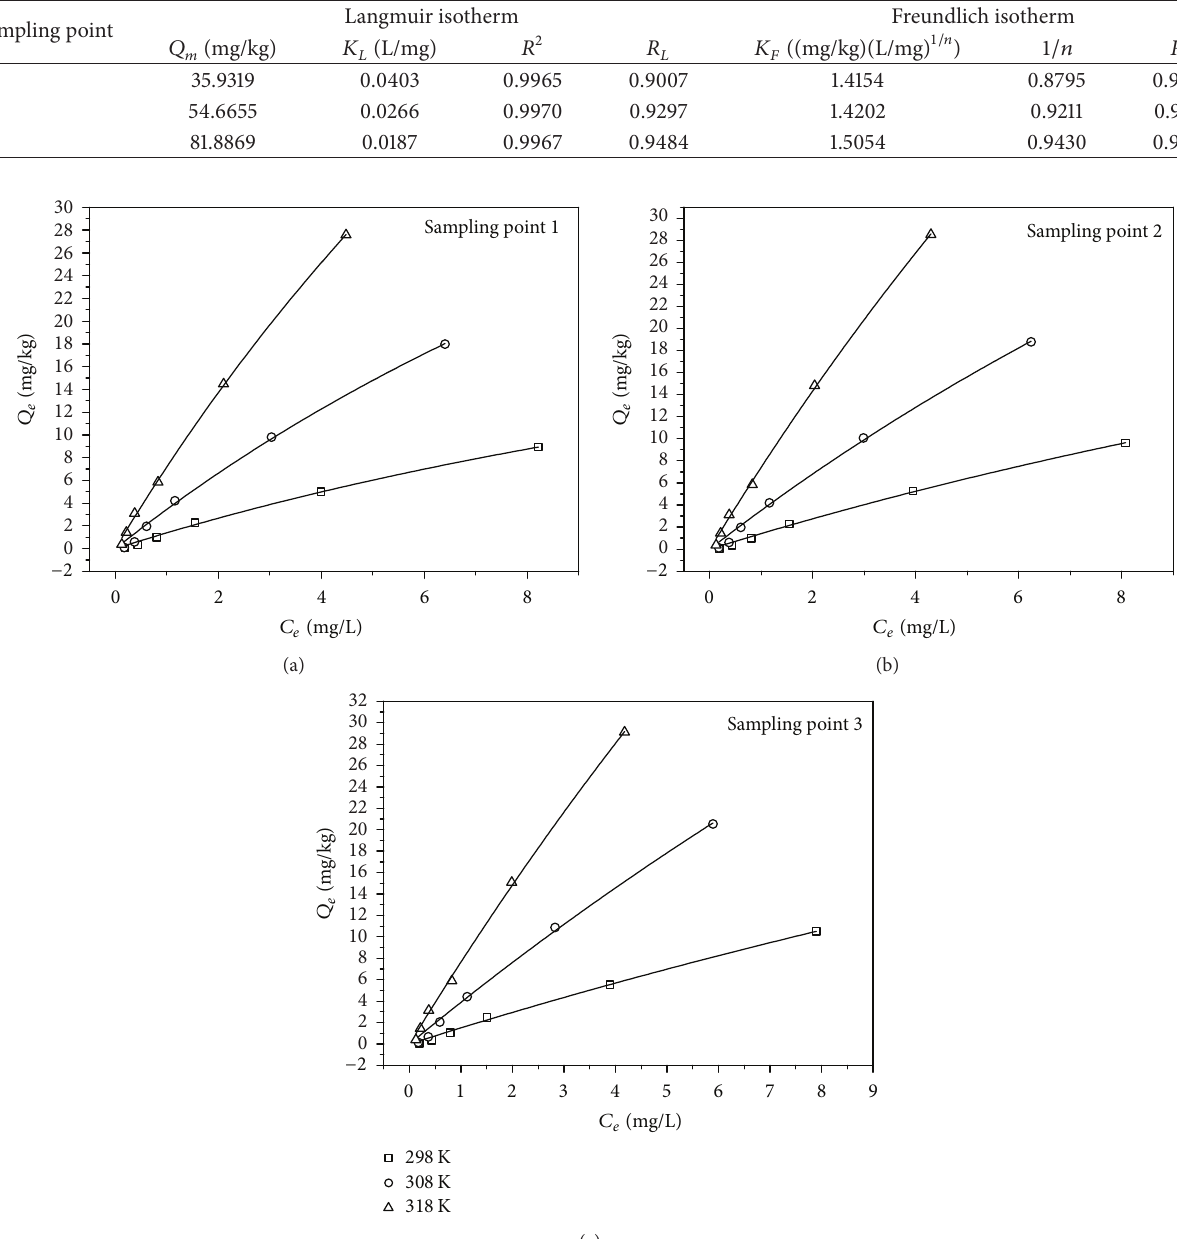
Table 3: Isotherm parameters for OTC adsorption onto sediment samples.